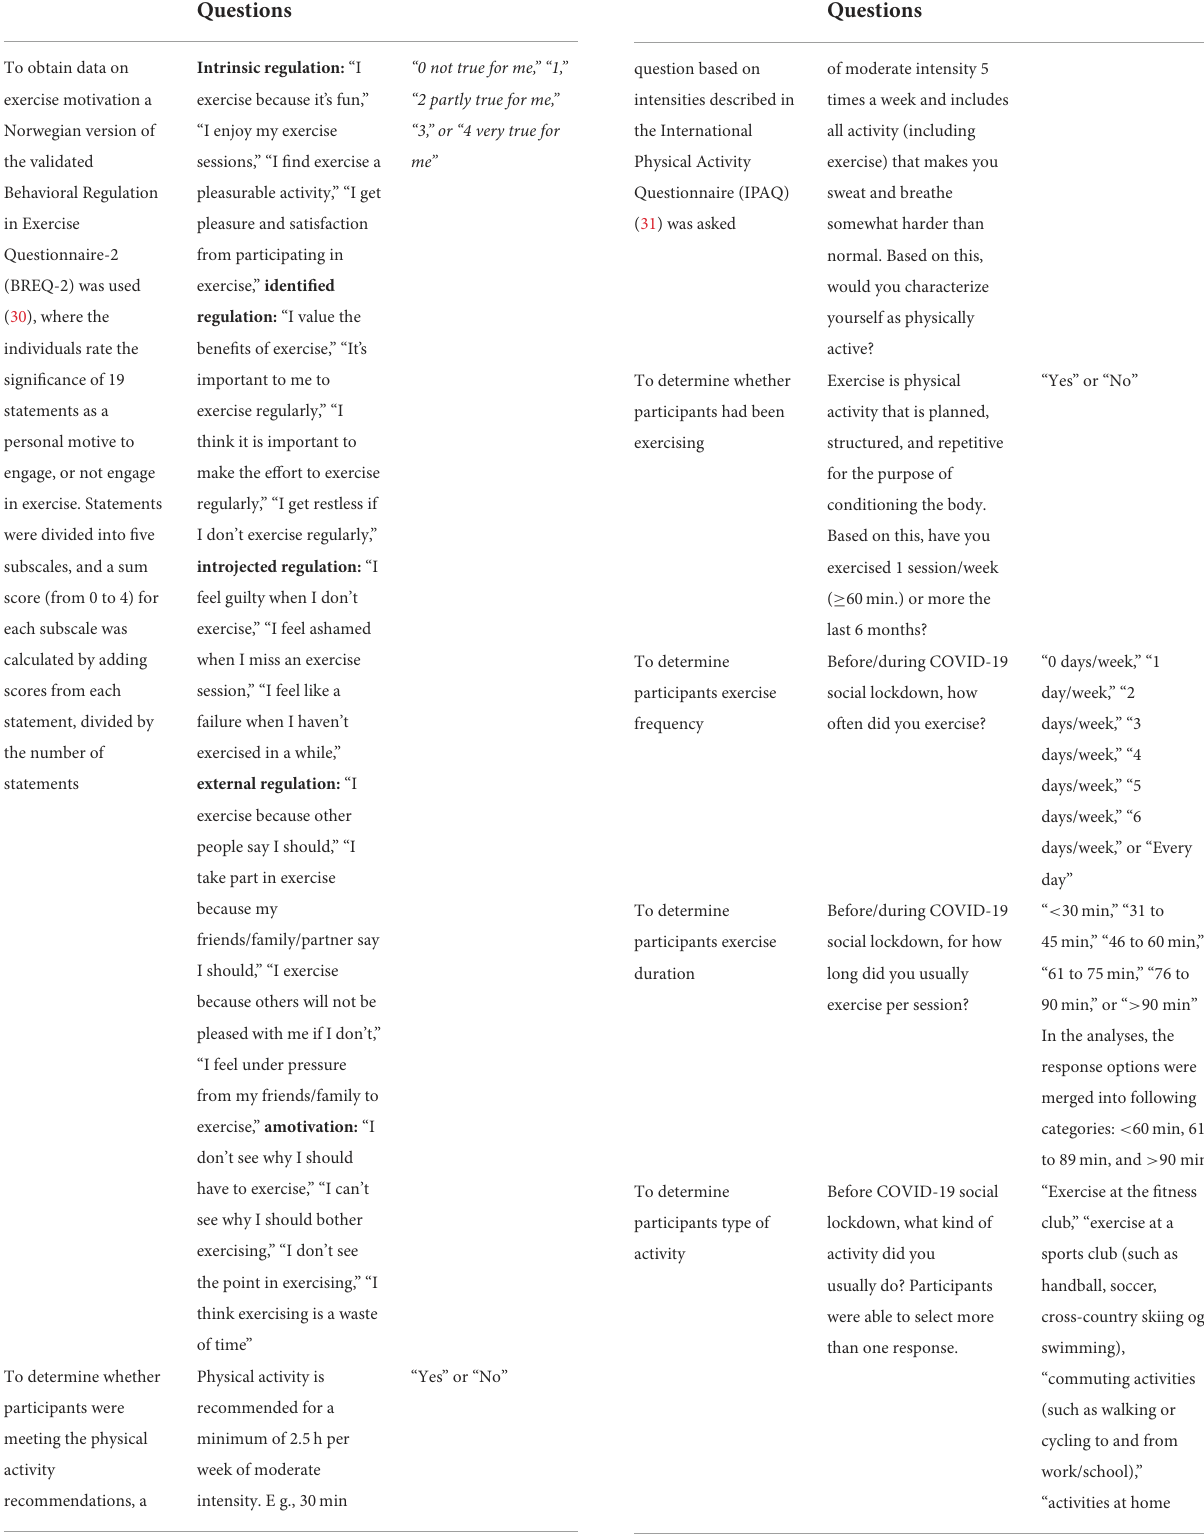
TABLE 1 Questions used to answer the present study